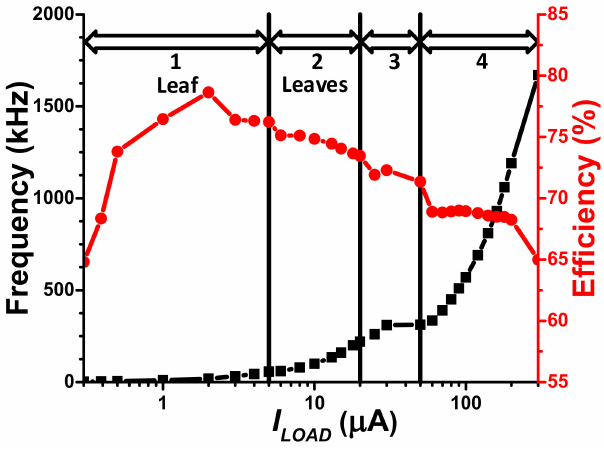
Figure 20. Frequency, efficiency and active leaves vs. I